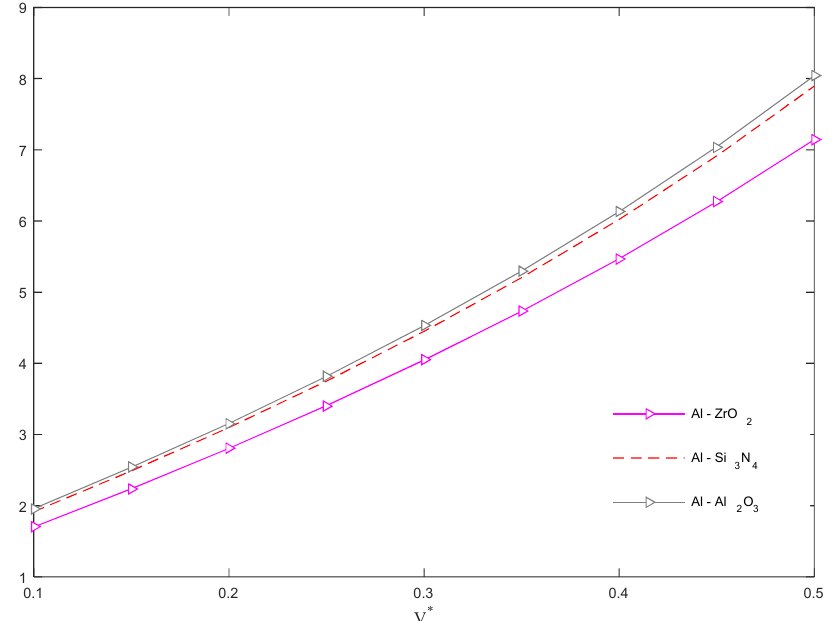
Figure 8. Dimensionless critical buckling load versus CNT volume fraction for different FGC material constituents.